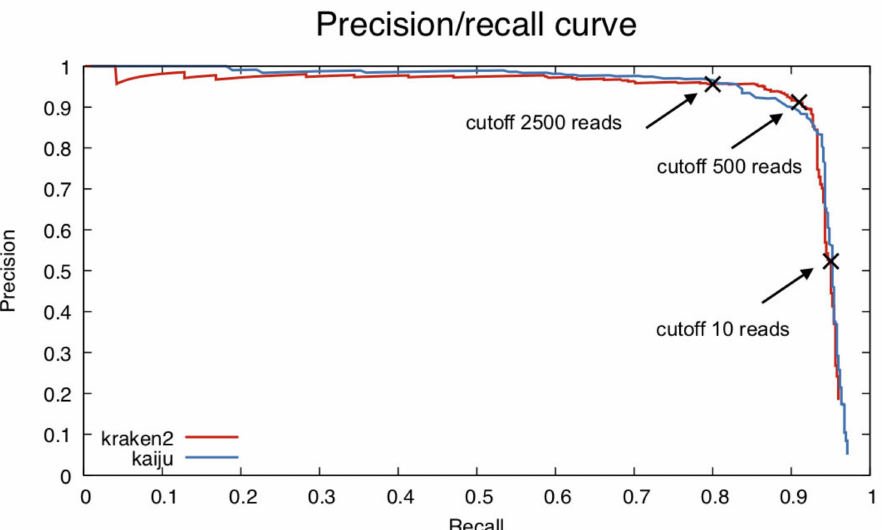
Figure 2. Precision/recall curves for the classifiers Kraken 2 and Kaiju with the simBA525 dataset according to Ye et al. in 2019 [3]. Each point in the curves represents the precision and recall score for a specific read abundance threshold, calculated on a simulated dataset. We observed a sharp decrease in precision when the threshold was below 500 reads per species, indicating many false-positive species with low abundance. The figure also shows the cutoff values for recall of 0.8 and 0.95 at 2500 and 10 reads,